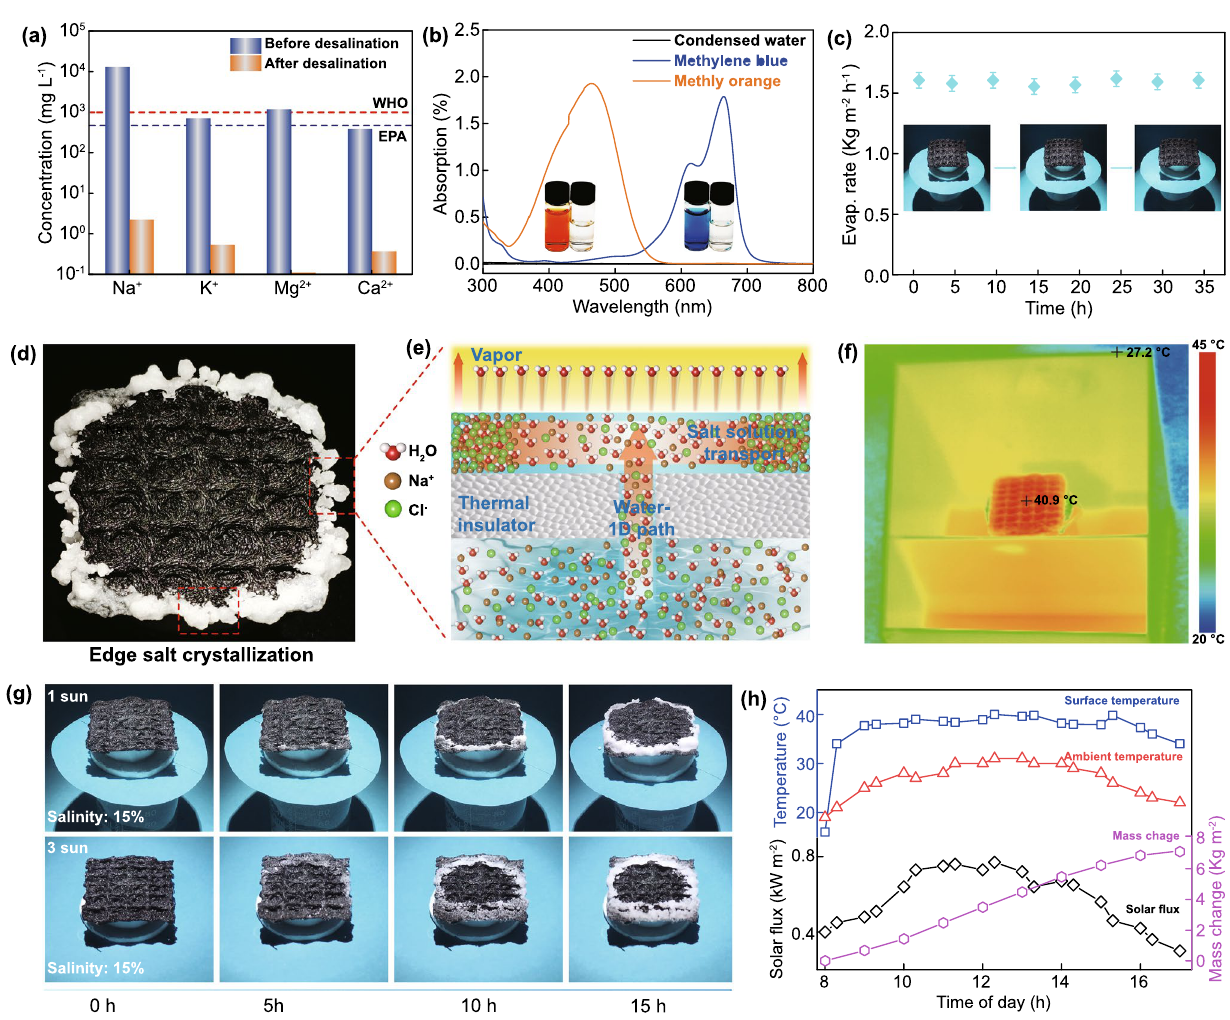
Fig. 5 a Concentrations of major cations in real seawater (Yellow Sea, China) before and after desalination. b UV–vis absorption spectra of methylene blue (MB) and methyl orange (MO) solutions before evaporation and the corresponding condensed water after evaporation. c Com- parison diagram of a honeycomb fabric-based evaporator before and after 35 h of continuous evaporation. d Digital image of salt accumulation at the edge of the evaporator. e Schematic diagram of water evaporation, water transport, and salt accumulation in a solar steam generator. f IR image of the solar after 20 min of solar irradiation. g Digital image of salt accumulation under the irradiation of 1 and 3 solar intensities with salt concentration of 15%. h Variations in solar intensity, honeycomb fabric surface temperature, ambient temperature, and evaporation mass with time from 8:00 to 17:00 (Nov. 12, 2020; Qingdao,